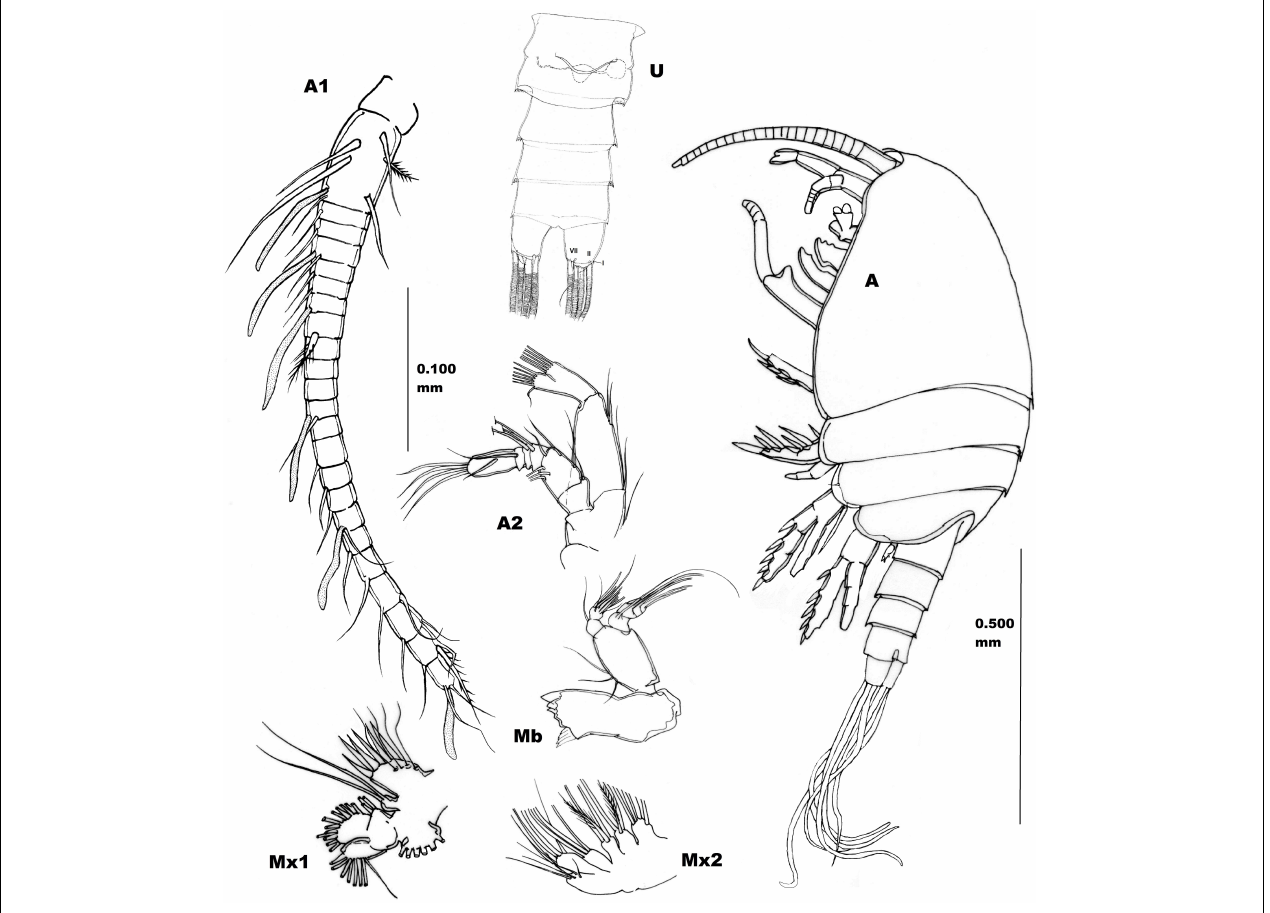
FIGURE 2 | Adult female holotype (RMNH.CRUS.F.4200) of Stygocyclopia badinoi n.sp. Lateral view, left side. Scale bar, 0.500 mm. U, Urosome, ventral view, and Cefalic metameric appendages (from paratypes), scale bar, 0.100 mm. A1, Antennule; A2, Antenna; Mb, Mandible; Mx1, Maxillule; Mx2, Maxilla. Roman numbers I, II, and VII indicate setae of furcal